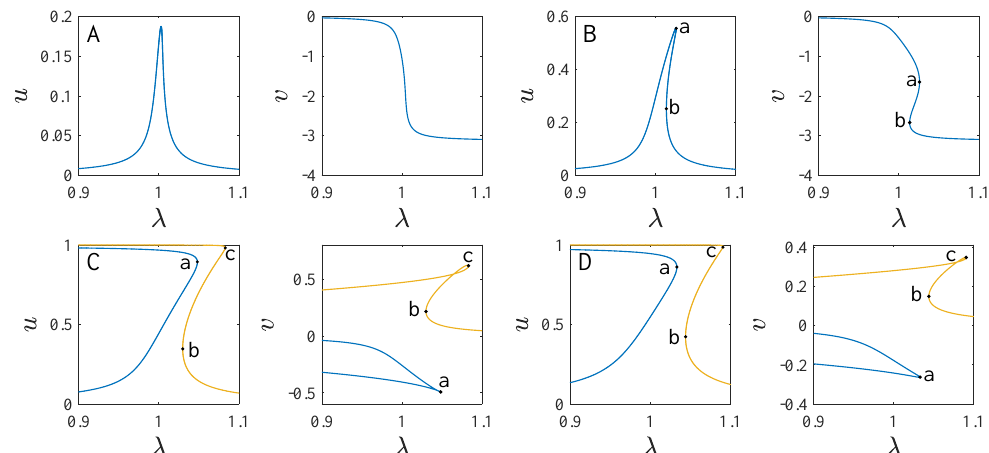
Figure 13. The projections of the bifurcation diagrams corresponding to different persistent regions in Figure 12.